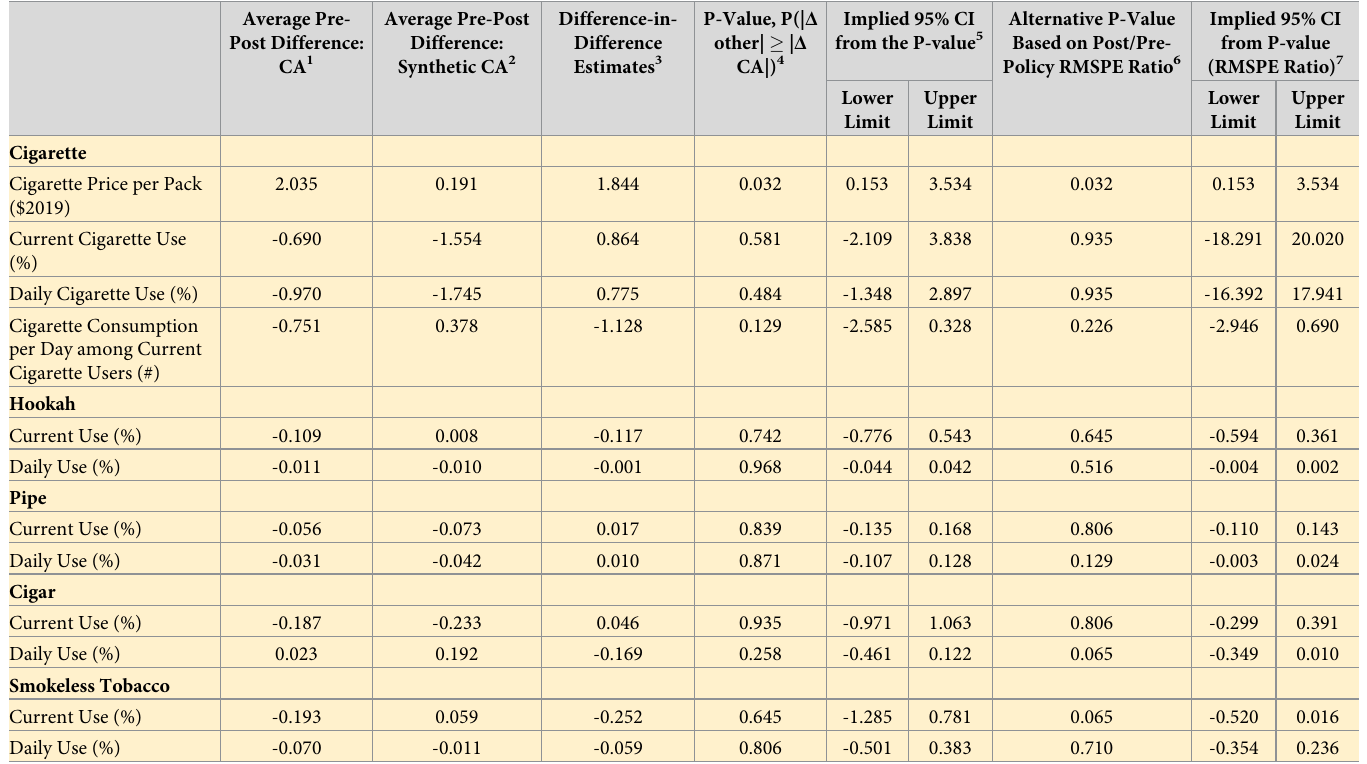
Table 4. Difference-in-differences estimates on the associations between California Proposition 56 tobacco tax increase and tobacco outcomes. Average Pre- Post